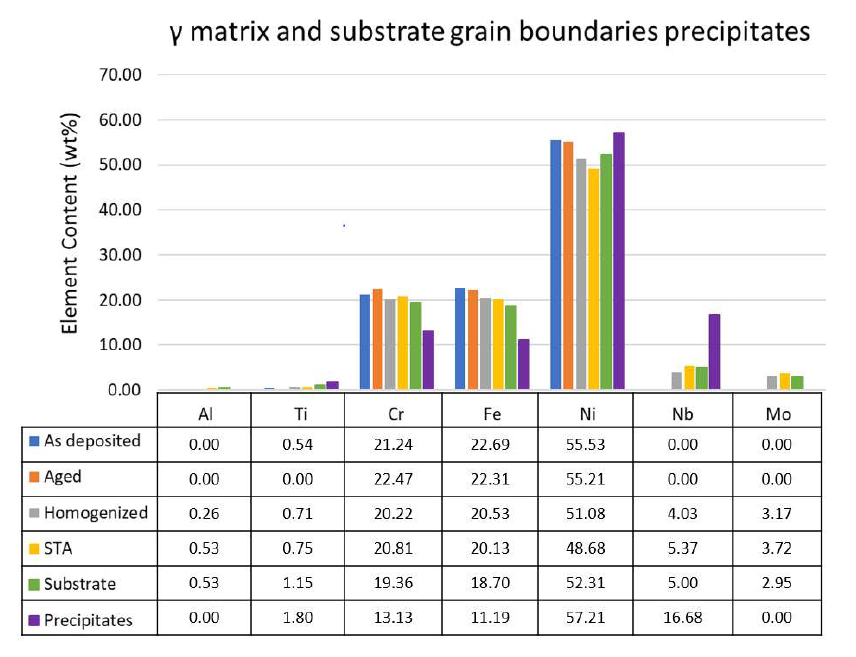
Figure 14. Comparison of γ matrix in the different samples and the grain boundaries precipitates detected in the substrate of as-deposited and aged samples.